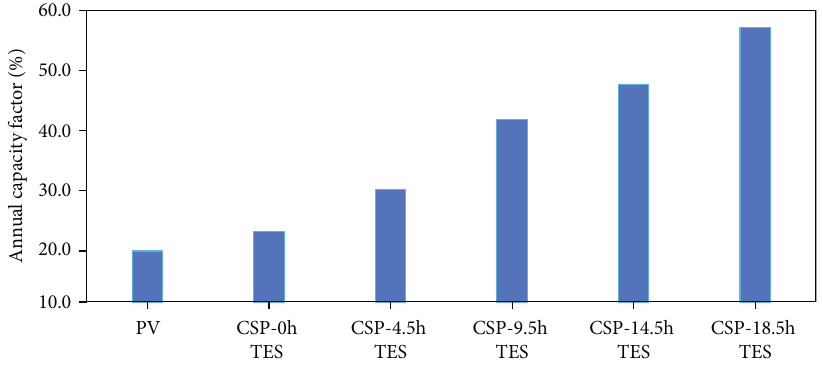
Figure 12: Annual capacity factor of PV and PT-CSP